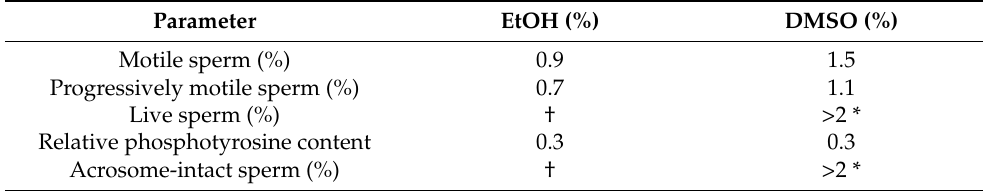
Table 4. Concentration of ethanol (EtOH) and dimethyl sulfoxide (DMSO) predicted to induce a 5% decline in sperm parameters using the linear mixed models. Parameter EtOH (%) DMSO (%) Motile sperm (%) 0.9 1.5 Progressively motile sperm (%) 0.7 1.1 Live sperm (%) † >2 * Relative phosphotyrosine content 0.3 0.3 Acrosome-intact sperm (%) † >2